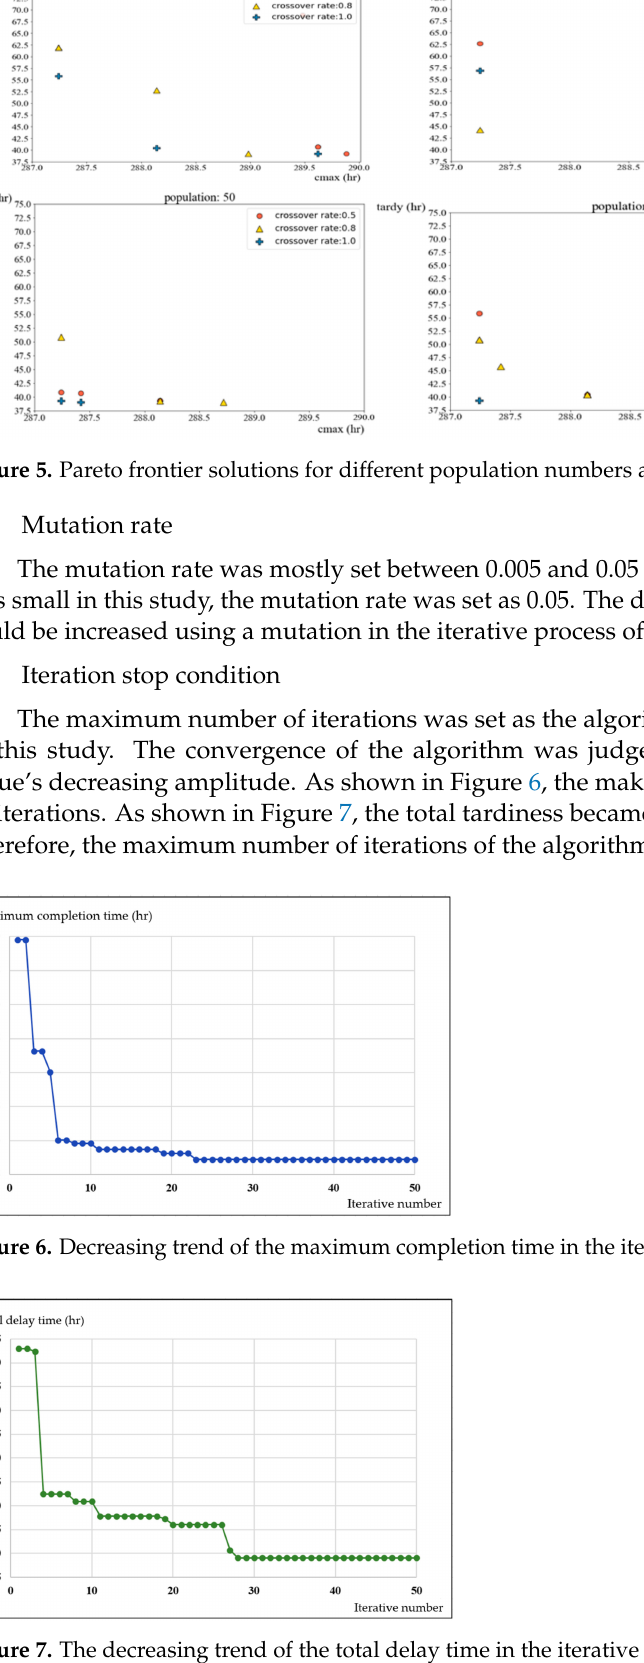
Figure 7. The decreasing trend of the total delay time in the iterative process of the